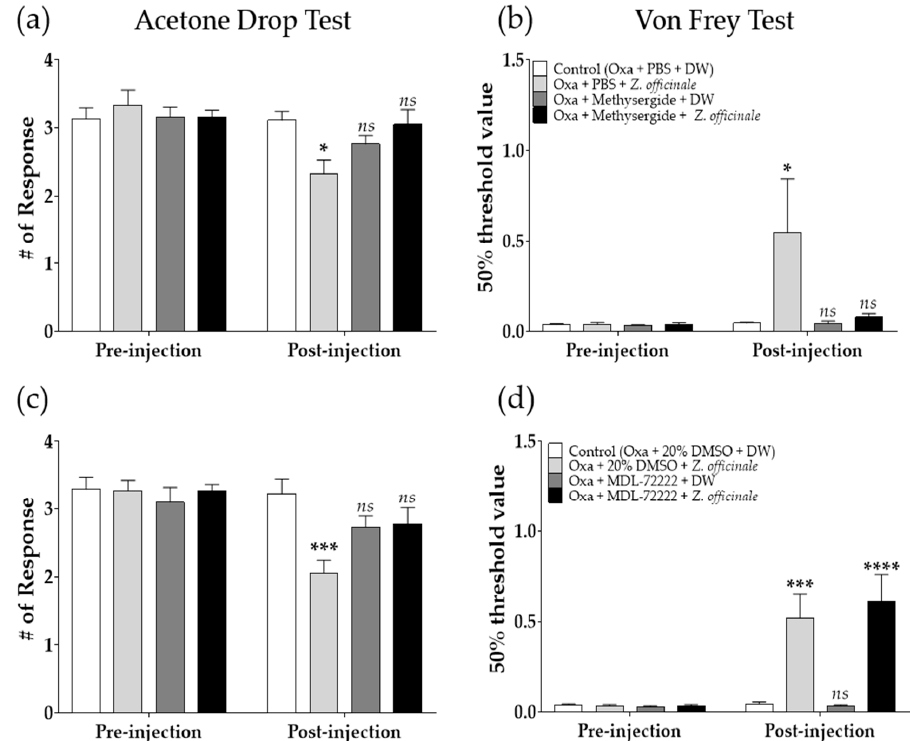
Figure 3. Effect of intrathecal administration of serotonin receptor antagonists on the analgesic effect of Z. officinale against oxaliplatin-induced neuropathic pain. The effect of methysergide ( a , b ) and MDL-72222 ( c , d ) on Z. officinale -induced inhibition of cold ( a,c ) and mechanical ( b , d ) allodynia. When significant allodynic signs were observed in oxaliplatin-treated mice, methysergide or MDL-72222 was injected intrathecally in mice. PBS or 20% DMSO was used as a control for methysergide and MDL-72222, respectively. Z. officinale or DW was administered orally 20 min after the administration of methysergide, MDL-72222, PBS, or 20% DMSO. Pre-injection: before the injection of PBS, methysergide, 20% DMSO, MDL-7222, and Z. officinale . Post-injection: After the injection of PBS, methysergide, 20% DMSO, MDL-7222, and Z. officinale . Cold and mechanical allodynia were assessed by using the acetone drop and von Frey filament tests, respectively.